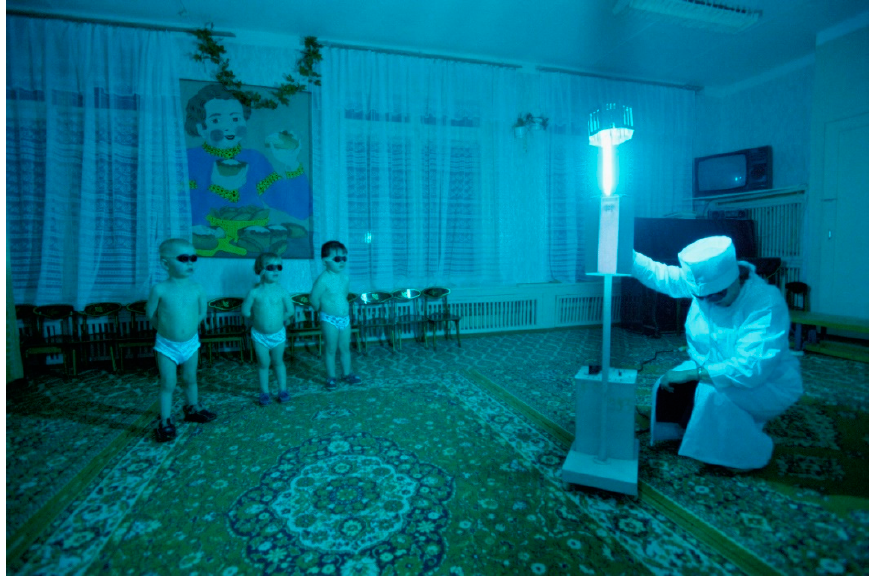
Figure 1. In sunless Lovozero, Russia, children bathe in ultraviolet light to produce vitamin D for their bones. Photo © Joe McNally.